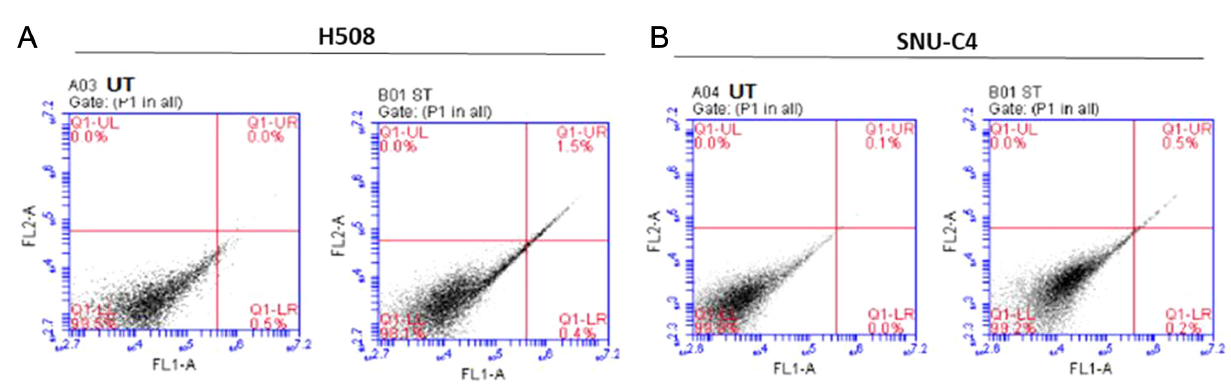
Figure 6. (A) Effects of sodium taurolithocholate (ST) on apoptosis of CHRM3 of H508 and (B) SNU-C4 human colon cancer cells. UT, Untreated. In all experiments, treatment with ST did not trigger apoptosis. The rate of apoptotic cells was calculated by qualitative flow cytometry using Annexin V and propidium iodide (PI) staining. Q1-LL quadrant (Annexin V FITC/PI) is viable cells; Q1-LR quadrant (Annexin V FITC+/PI) is early apoptotic cells; and Q1-UR and Q1-UL quadrants (Annexin V FITC+/PI+) are late apoptotic and necrotic, respectively. LL, lower left; LR, lower right; UL, upper left; UR, upper right. (A) H508 human colon cancer cell. (B) SNU-C4 human colon cancer cell. Table 2. The Result of KEGG and GO Enrichment Analysis for the 10 Differentially Expressed miRNAs ( P <